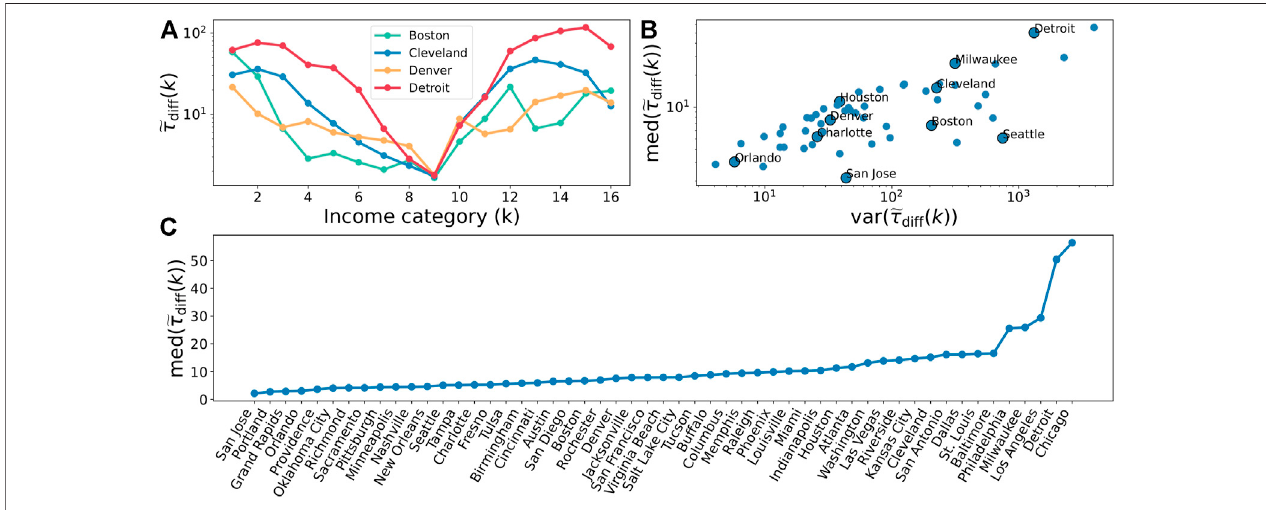
FIGURE 1 | Diffusion dynamics as a measure for income segregation. (A) Synchronization time for each of the 16 income categories in Boston, Cleveland, Denver and Detroit. (B) Median value of ~ τ diff ( k ) across income categories as afunction ofits variance. (C) Ranking for the median value of ~ τ diff ( k ) for thestudied set ofUS cities.